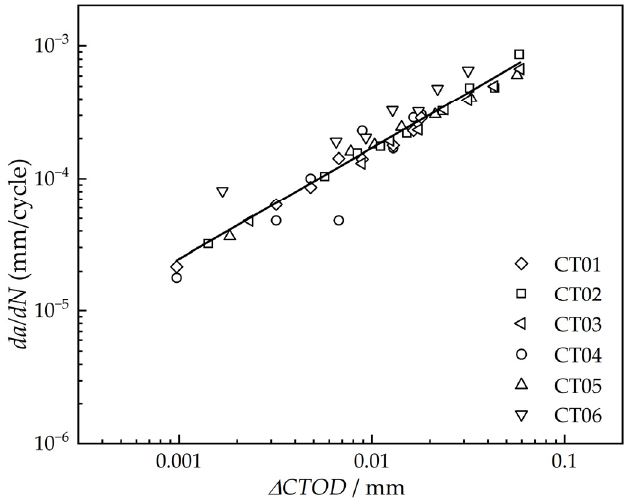
Figure 8. Crack propagation rate da/dN versus Δ CTOD curve.